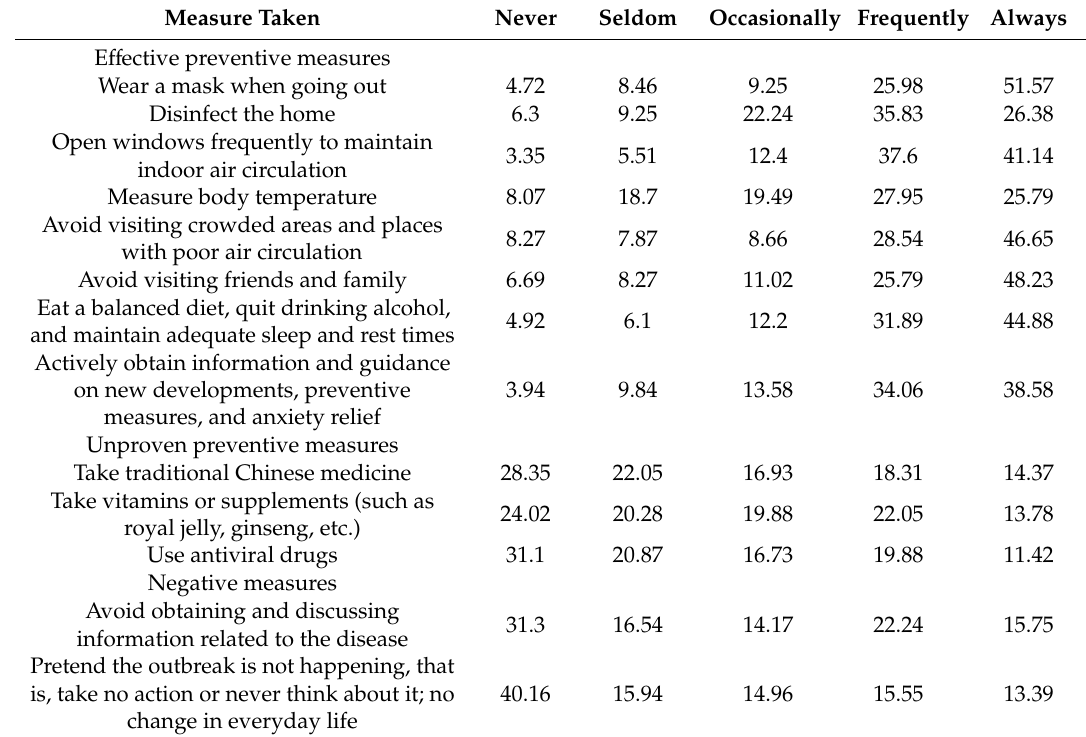
Table 3. Response measures taken by the elderly participants